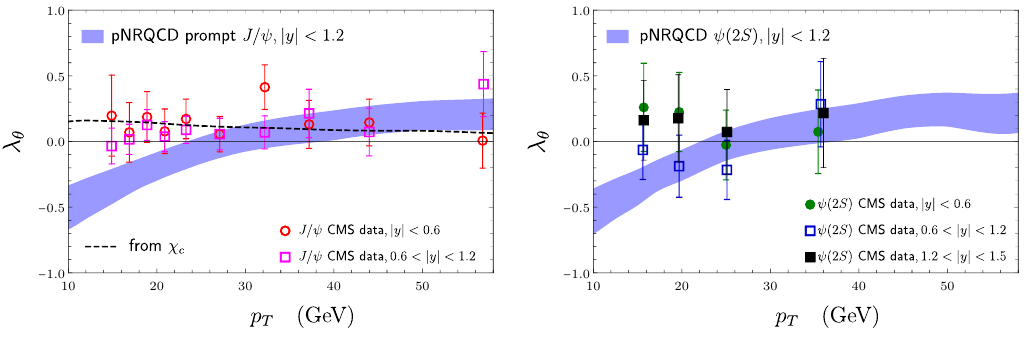
Figure 12 . pNRQCD results for the polarization parameter λ θ for prompt J/ψ (left) and ψ (2 S ) (right), compared to CMS data [79]. The polarization of J/ψ from χ c decays is shown as a black dashed